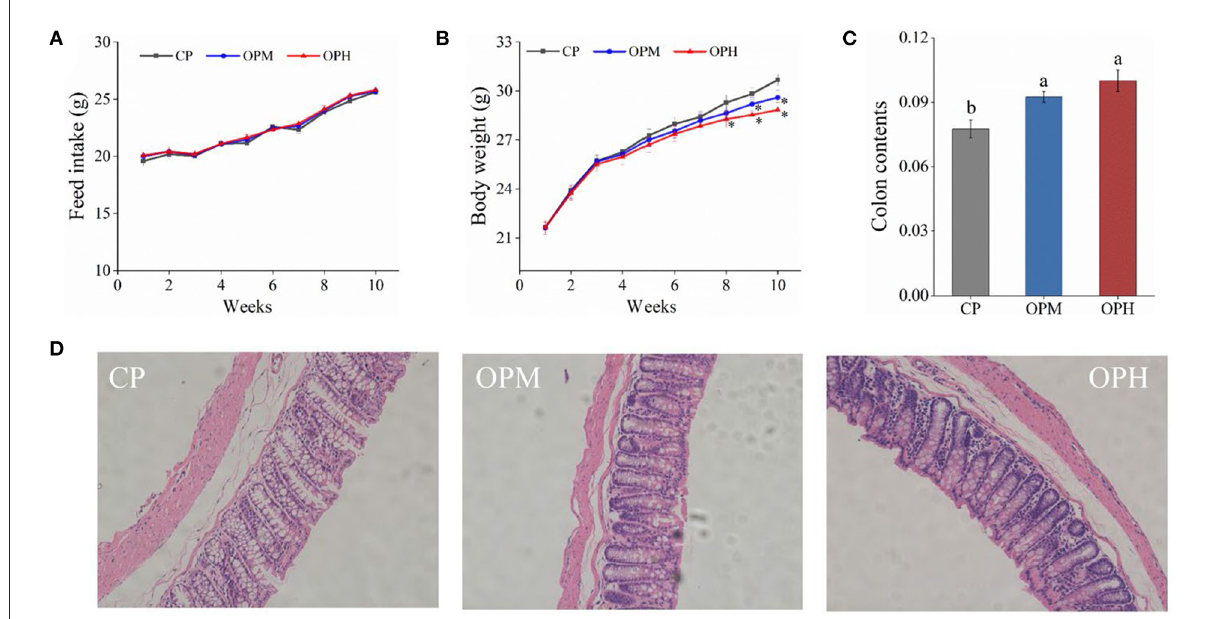
FIGURE1 Effects of consuming oxidized beef protein on body weight and colon development. (A) Feed intake; (B) Body weight; (C) Colon contents; (D) Colon development. The * indicates a significant difference ( p < 0.05) from the CP group. Different letters (a,b) represent significant differences ( p < 0.05). The results were expressed in means ± SEM ( n = 8).